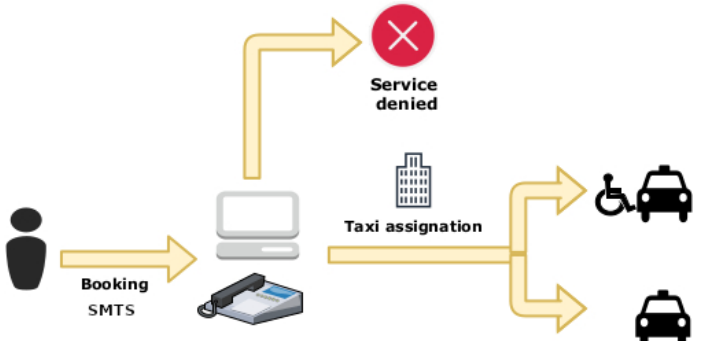
Figure 1. Workflow of the SMTS user request